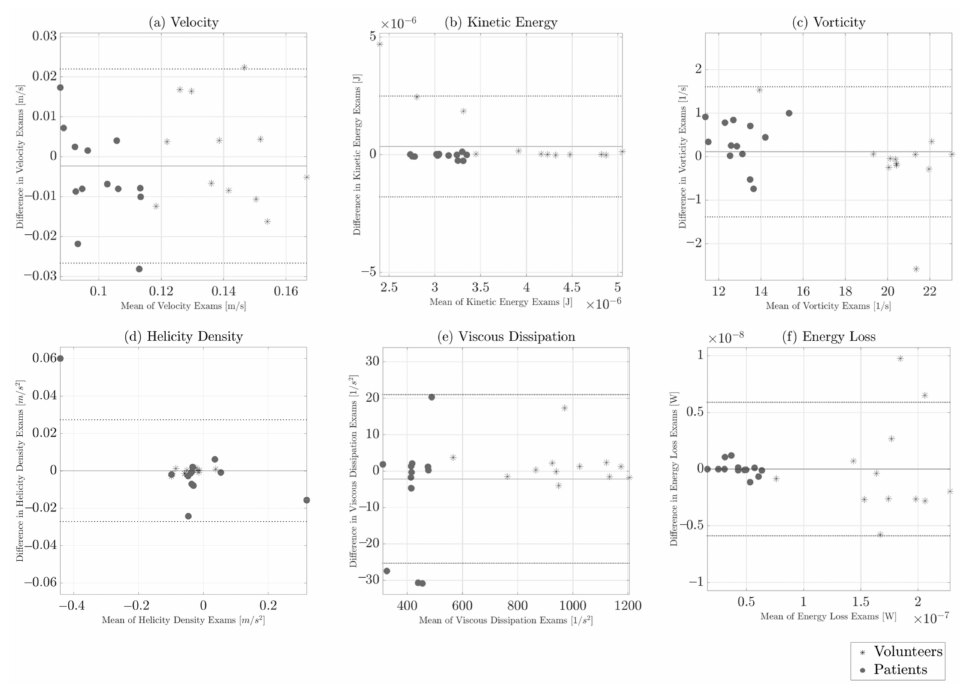
Figure A4. Bland-Altman plots represent the inter-observer reproducibility in the exams of LV global hemodynamic parameters ( a – f ) at peak systole. The thick line represents the mean difference, and the thin lines represent the limits agreement (1.96 SD).